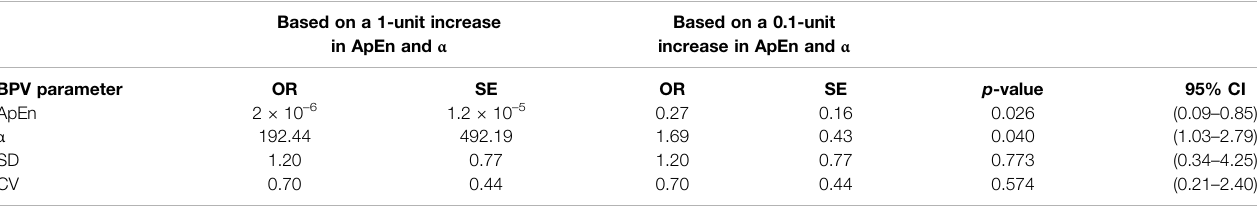
TABLE 3 | Odds ratio re fl ecting the potential predictive capacity of linear and nonlinear diastolic blood pressure variability parameters for early cardiovascular dysfunction associated with a mild metabolic challenge triggered by HC-feeding. Based on a 1-unit increase Based on a 0.1-unit in ApEn and α increase in ApEn and α BPV